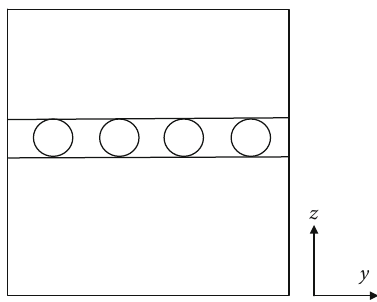
Figure 8: Multiple microsphere